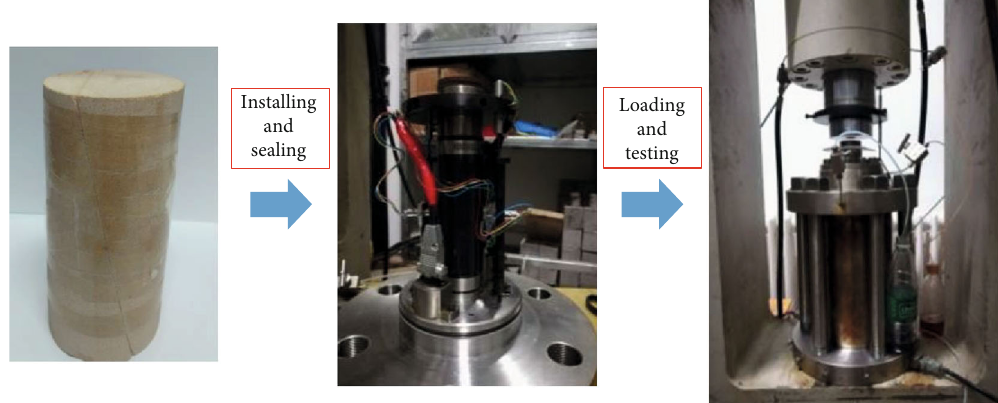
Figure 3: Triaxial hydromechanical coupling experiment process.